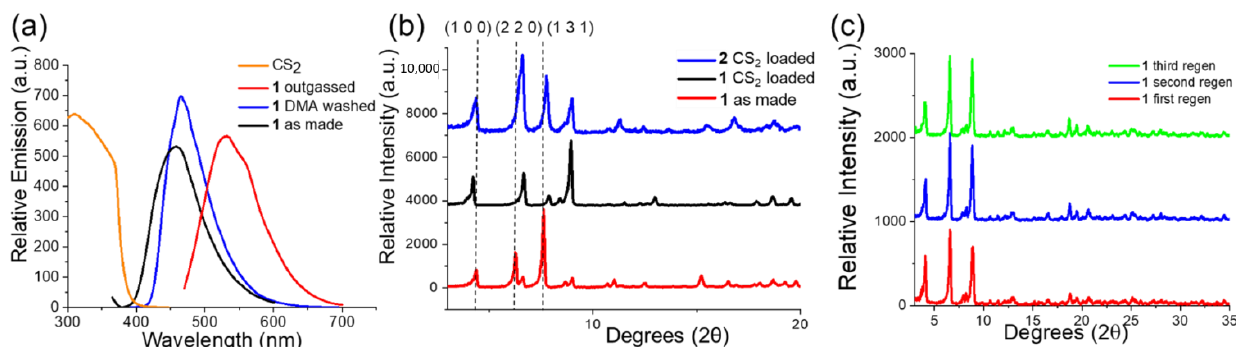
Figure 3. ( a ) The optical absorption spectrum of pure CS 2 and emission spectra of 1 in different forms (as-made, DMA washed and outgassed). ( b ) PXRD patterns of the as-made 1 and CS 2 -loaded 1 and 2 . ( c ) The PXRD patterns of 1 after three cycles of regeneration upon exposure to CS 2 , 1 M HCl, and